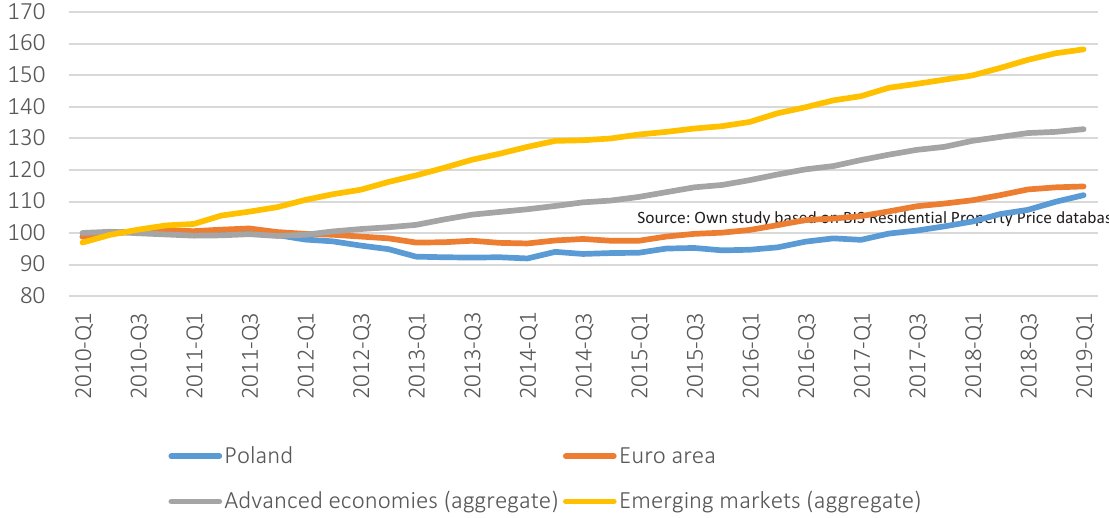
Figure 6. Index for quarterly residential property prices selected in Q1-2010–Q1-2019